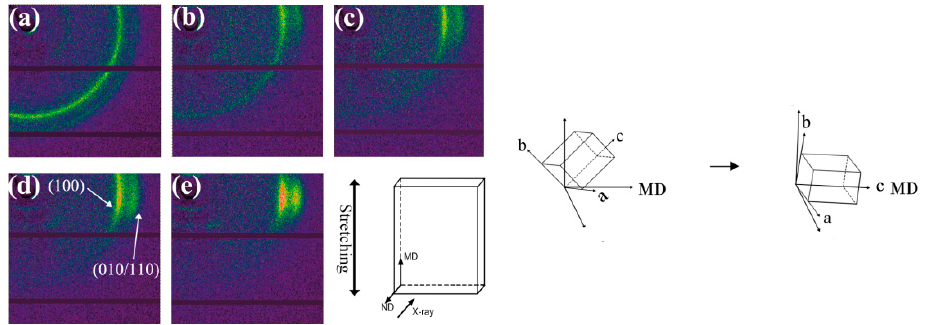
Figure 6. The 2D-WAXS of uniaxially stretched PA612/SiO 2 films at the strain of ( a ) ε = 0, ( b ) ε = 1, ( c ) ε = 1.5, ( d ) ε = 2, ( e ) ε =